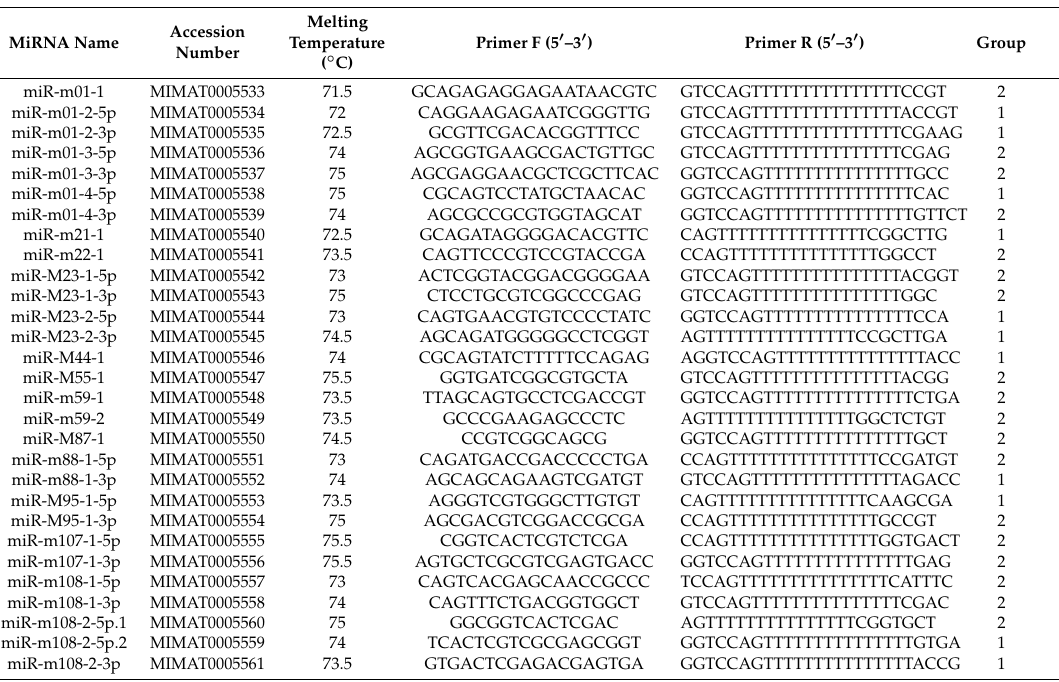
Table 1. Primers used to examine murine cytomegalovirus (MCMV)-encoded microRNAs (miRNAs) in real-time quantitative polymerase chain reaction (qPCR)